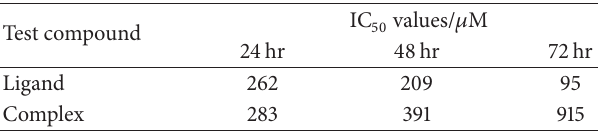
Table 8: IC 50 values reported for ligand and the complex at 24, 48, and 72 hr incubation